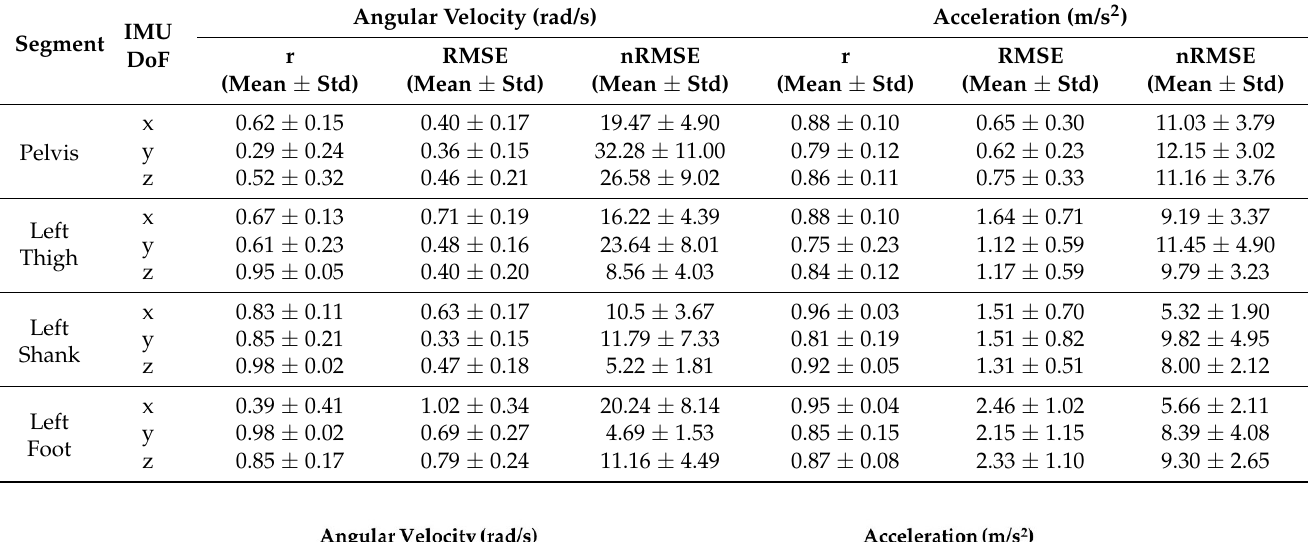
Table 2. Pearson correlation coeffecient (r) and root mean square error (RMSE) and of angular velocity and acceleration between simulated and measured IMU data across all subjects and trials.